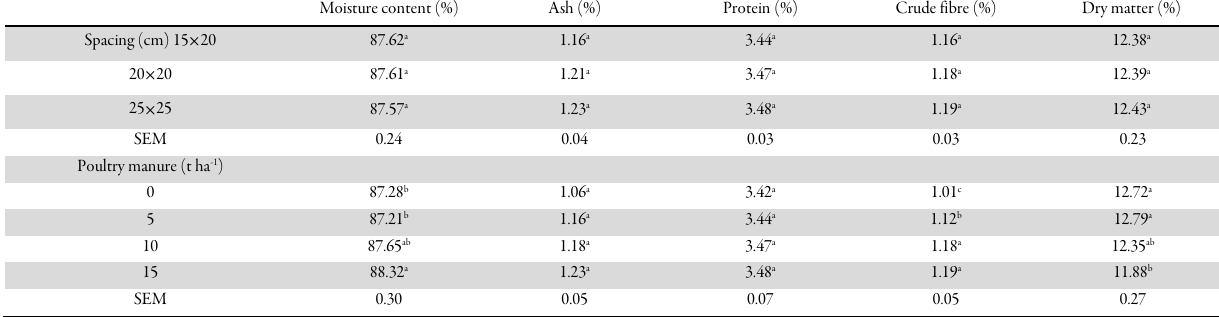
Table 8. Effect of poultry manure rates and spacing on the proximate composition of onion leaves